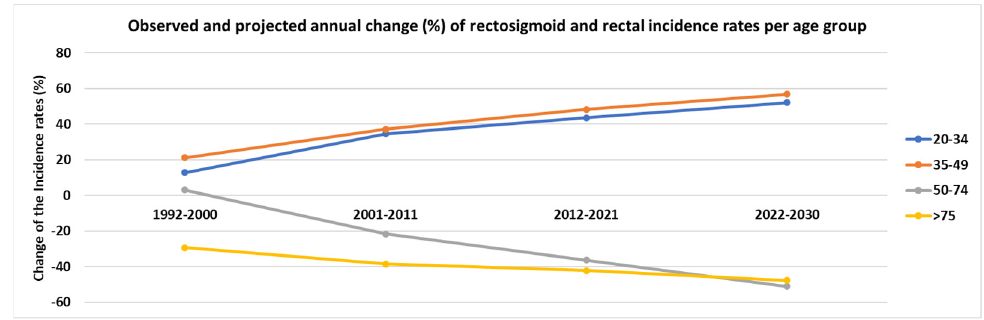
Figure 4. Observed and projected annual change (%) of rectal cancer incidence rates per age group.